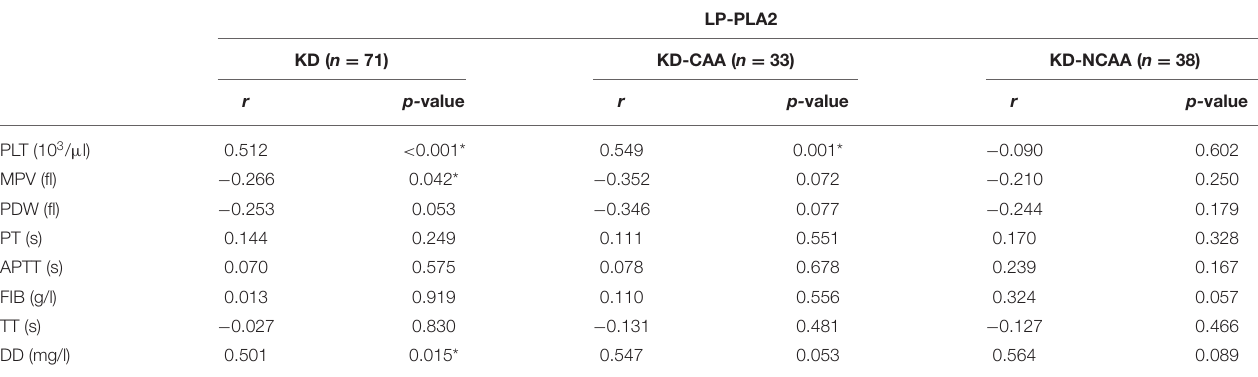
TABLE 5 | Correlations between serum Lp-PLA2 levels and blood coagulation parameters.